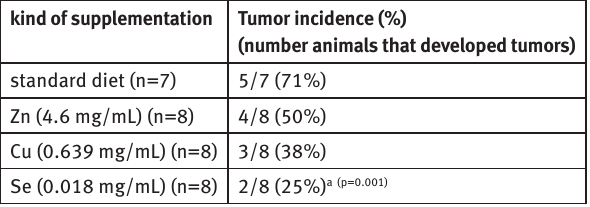
Table 1: Tumor induction in relation to supplementation. kind of supplementation Tumor incidence (%) (number animals that developed tumors) standard diet